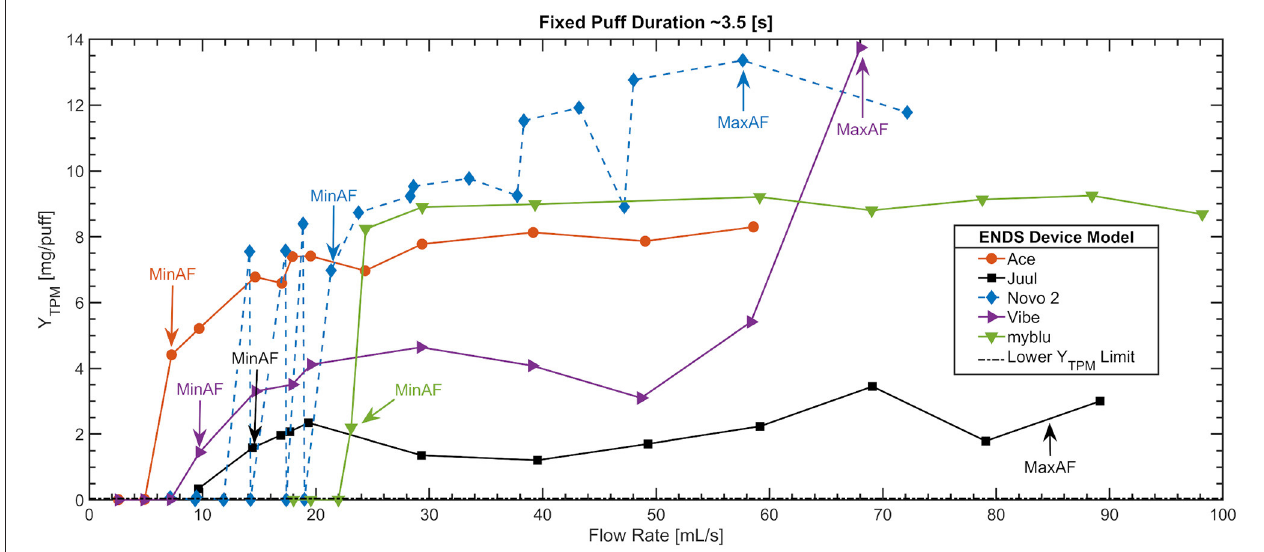
FIGURE 2 | Minimum and maximum activation flow rate, MinAF and MaxAF, for 5 of the 13 ENDS devices tested. Shown is the mean TPM yield per puff for each flow rate condition, based on nominally 50 puffs per flow rate conditions. Puffs were square-wave and nominally 3.5s in duration, with 30s puff period.